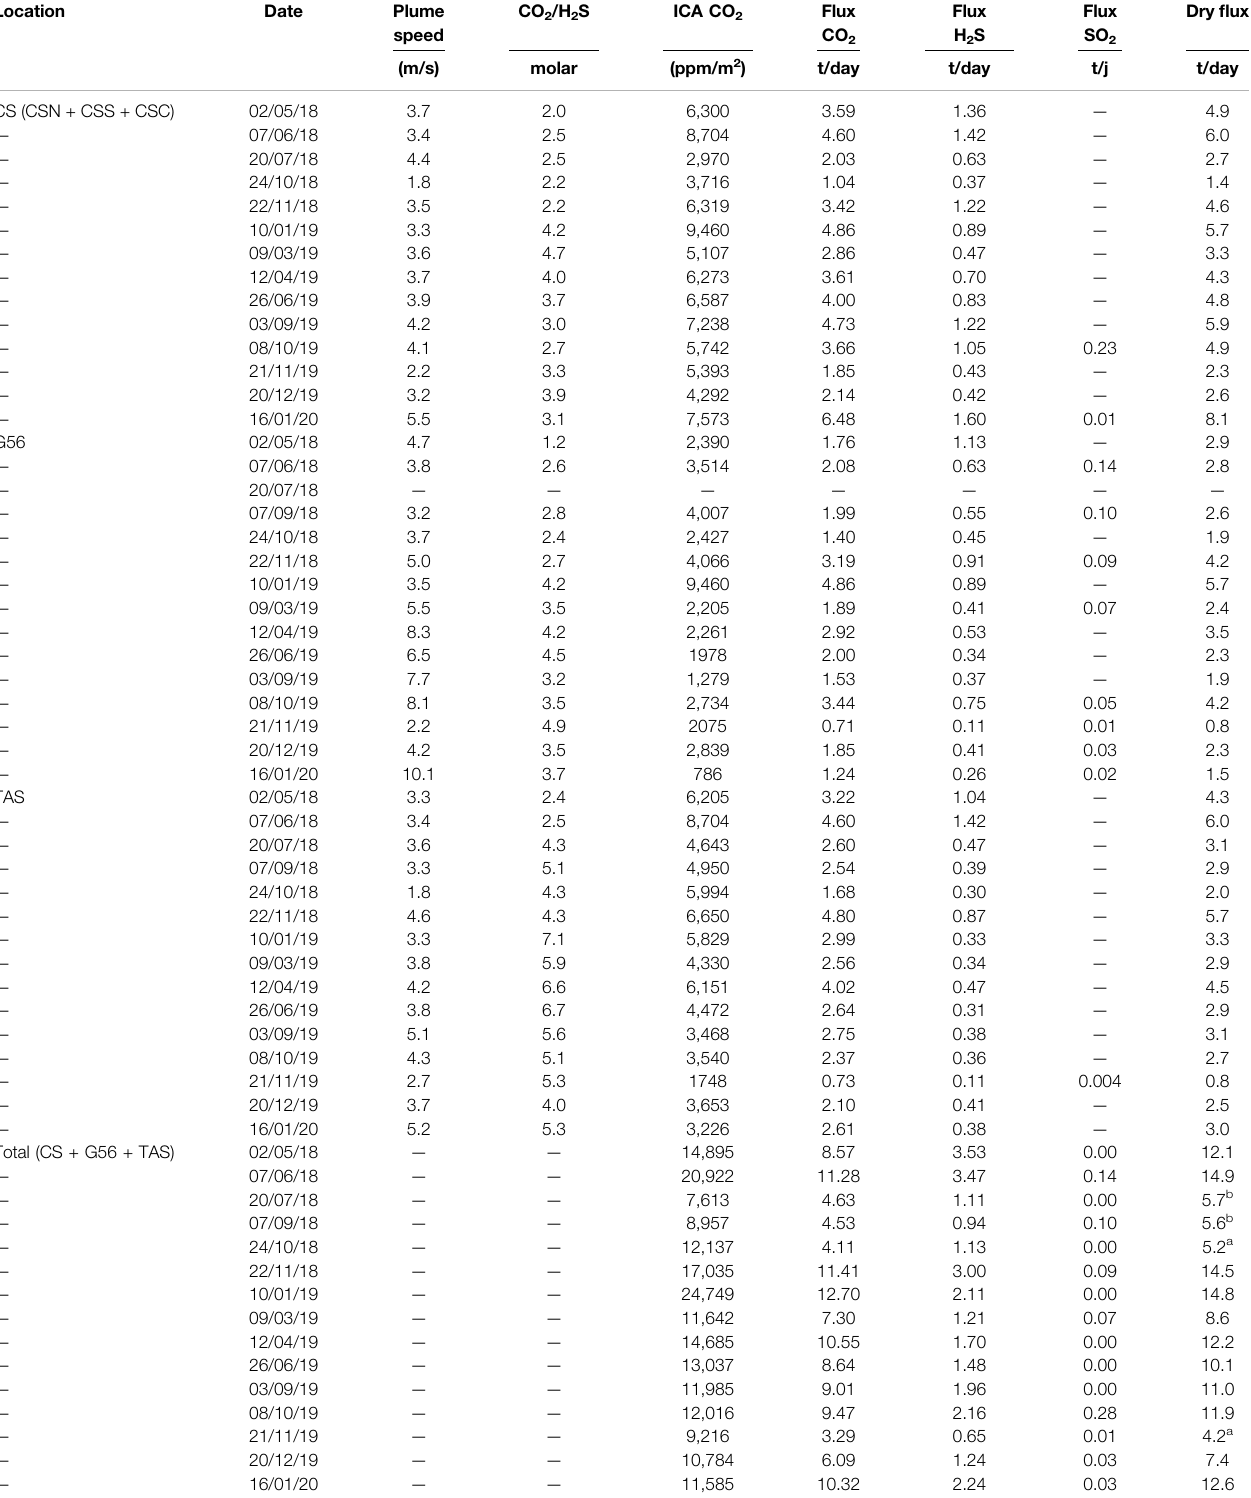
TABLE 2 | CO 2 , H 2 S and SO 2 fl uxes in tonnes per day, at La Soufrière in 2018 – 2020, computed from CO 2 ICAs and gas moral ratios ( Table 1 ). Dry gas fl ux is calculated as thesumofCO